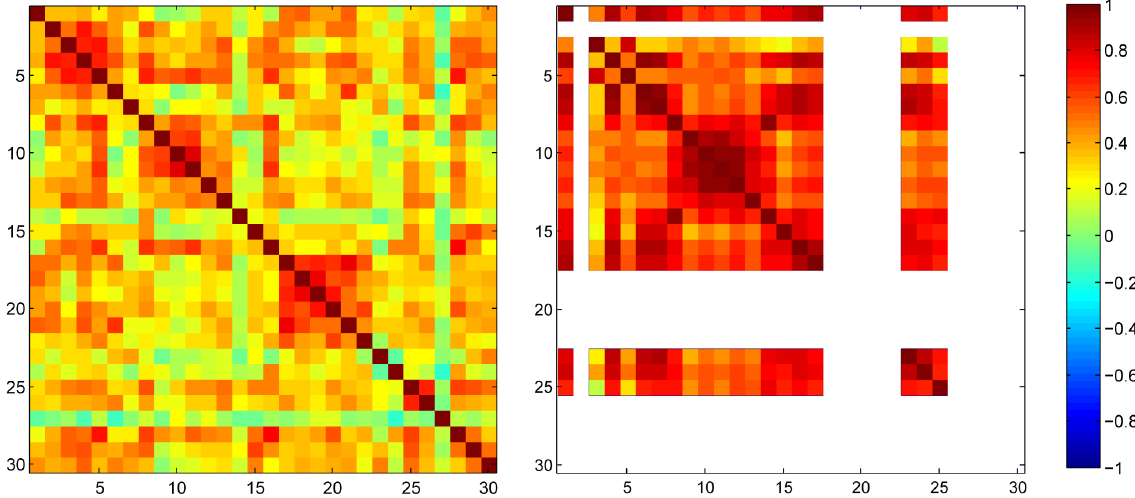
Fig. 5. Spearman correlation coefficients between the different groundwater sites (the numbers correspond to the sites as defined in Table 1 and Fig. 1) for groundwater data (left) and calculated deep percolation (right).